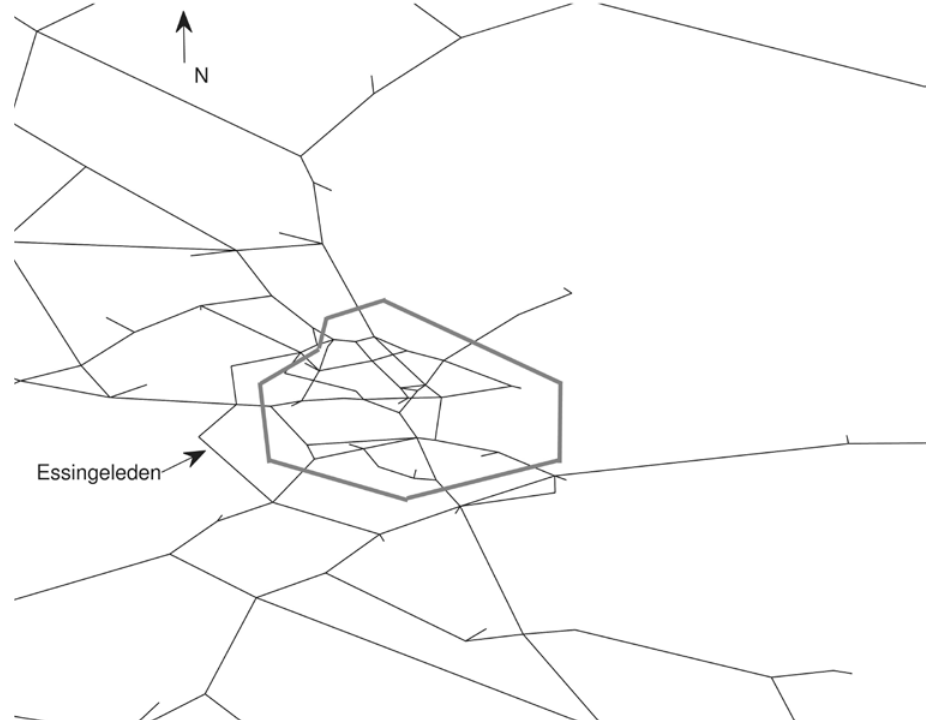
Figure 3. The current congestion pricing cordon in Stockholm.